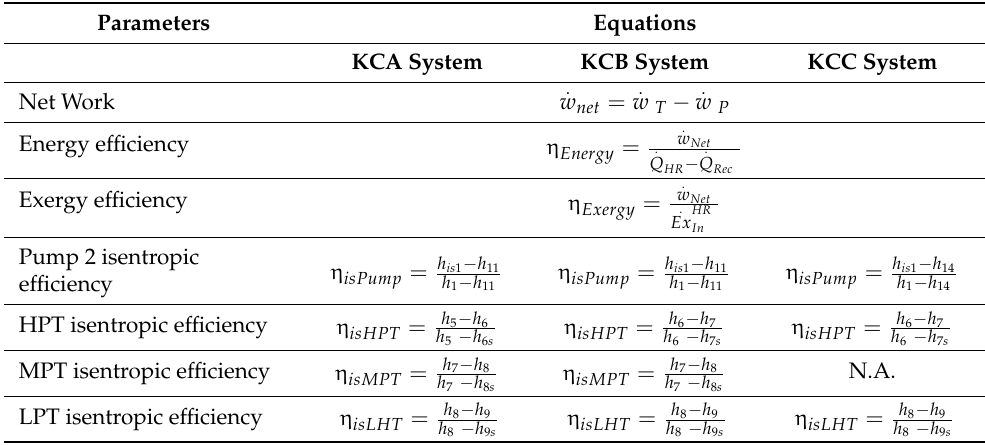
Table 6. Performance criteria of Kalina cycle.